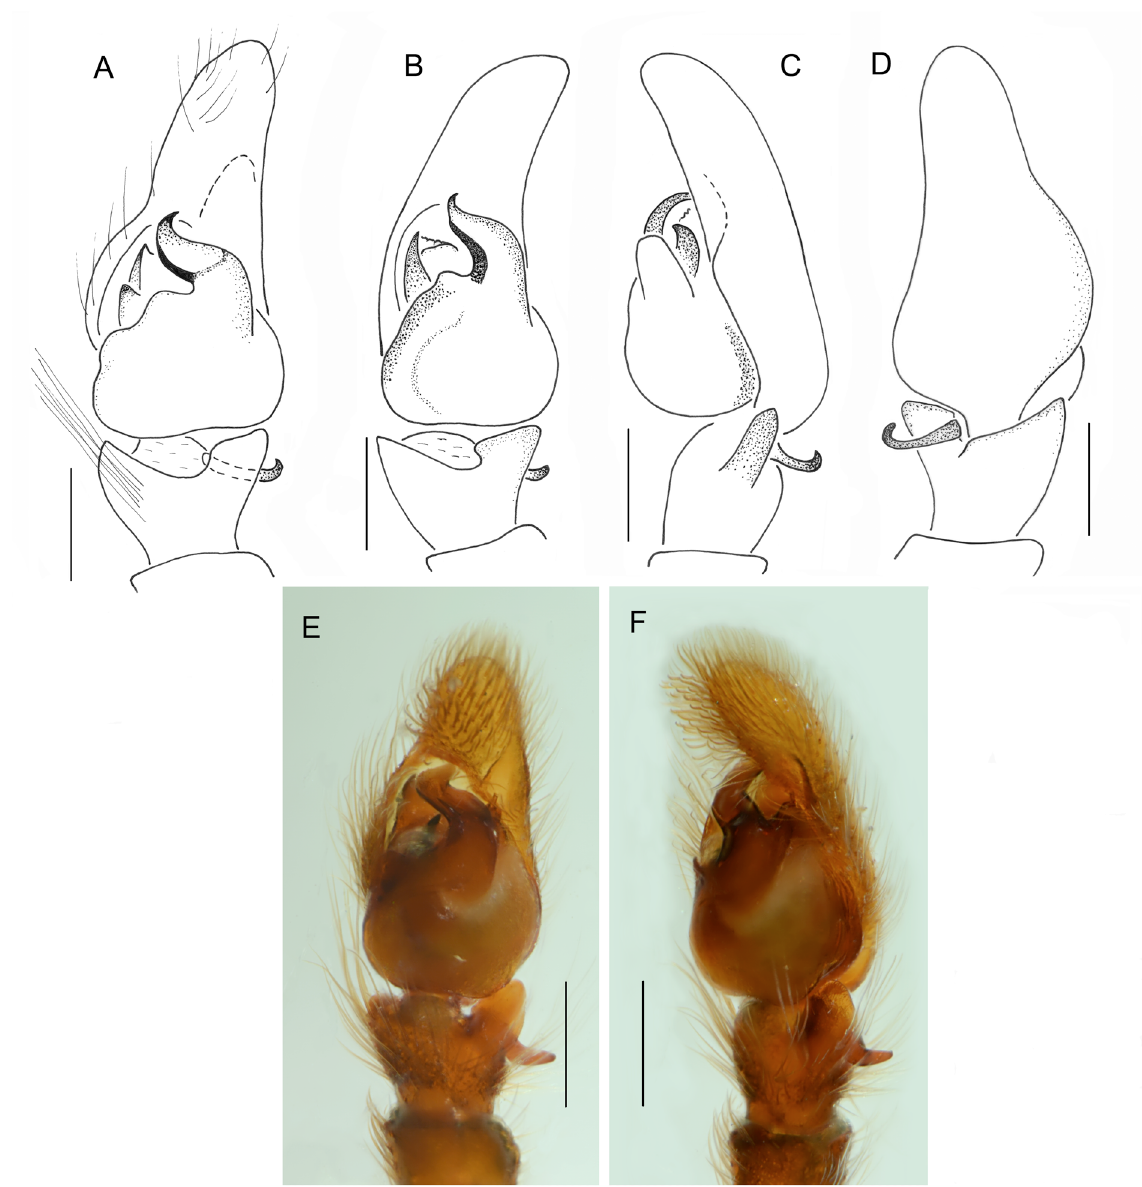
Fig. 1. Pochytoides lamottei sp. nov., ♂, holotype (A–D) and paratypes (e–F). A–E . Palpal organ. A , E . Ventral view. B . Ventroprolateral view. C . Retrolateral view. D . Dorsal view. F . Ventroretrolateral view. scale bars: 0.3